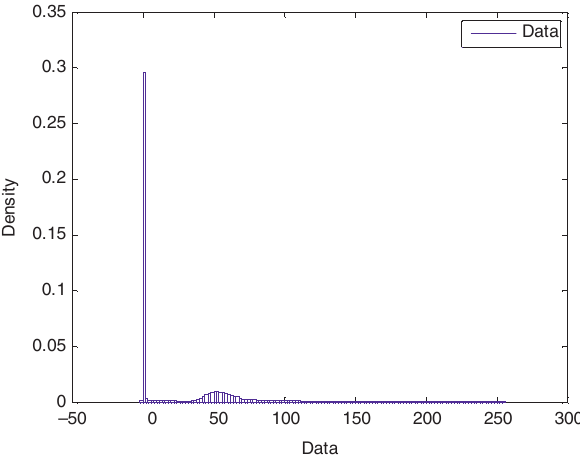
Figure 1: Three-Level Wavelet Decomposition of MR